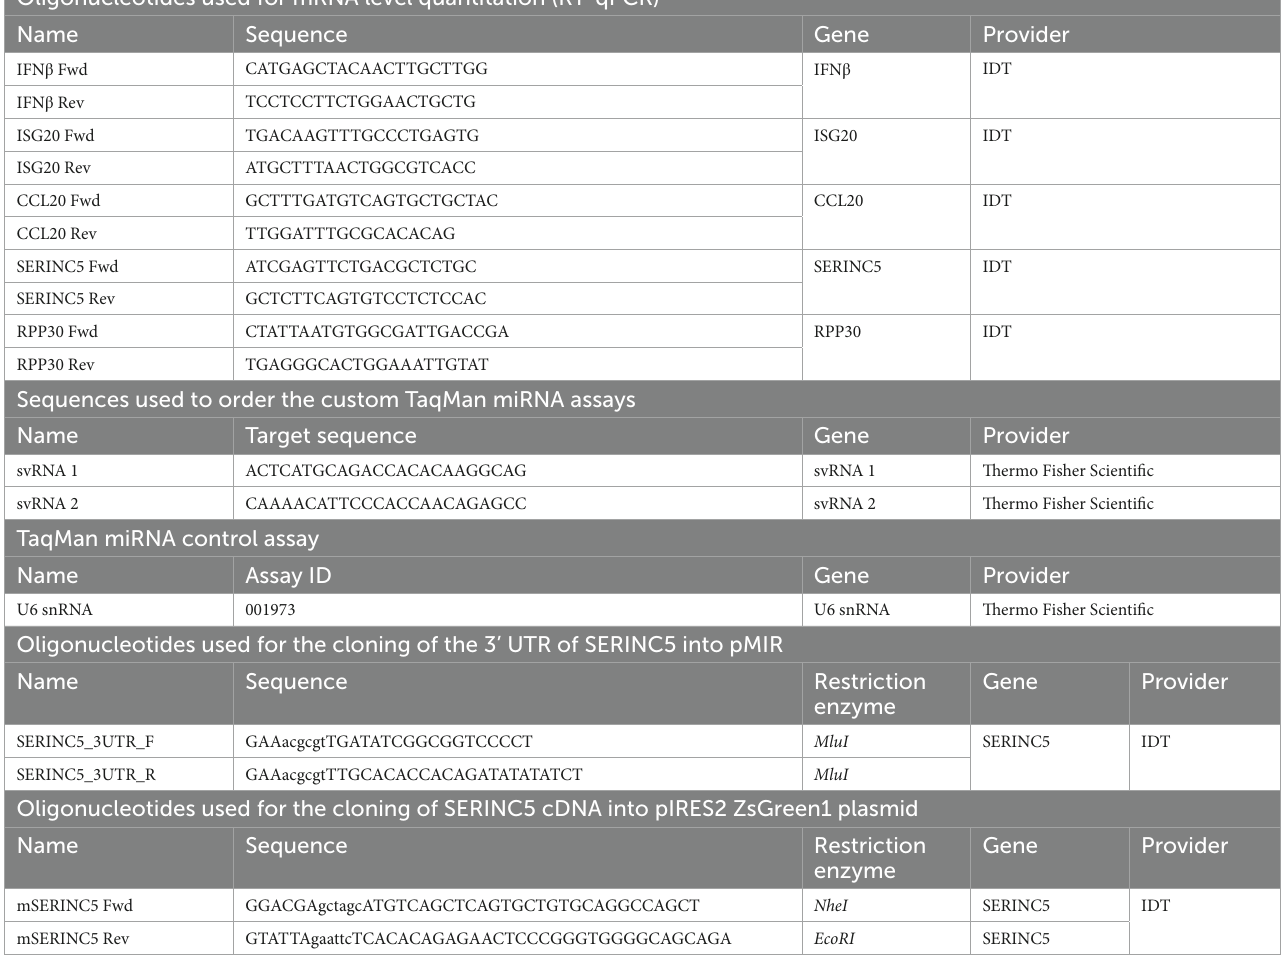
TABLE 1 Oligonucleotides used in the study.